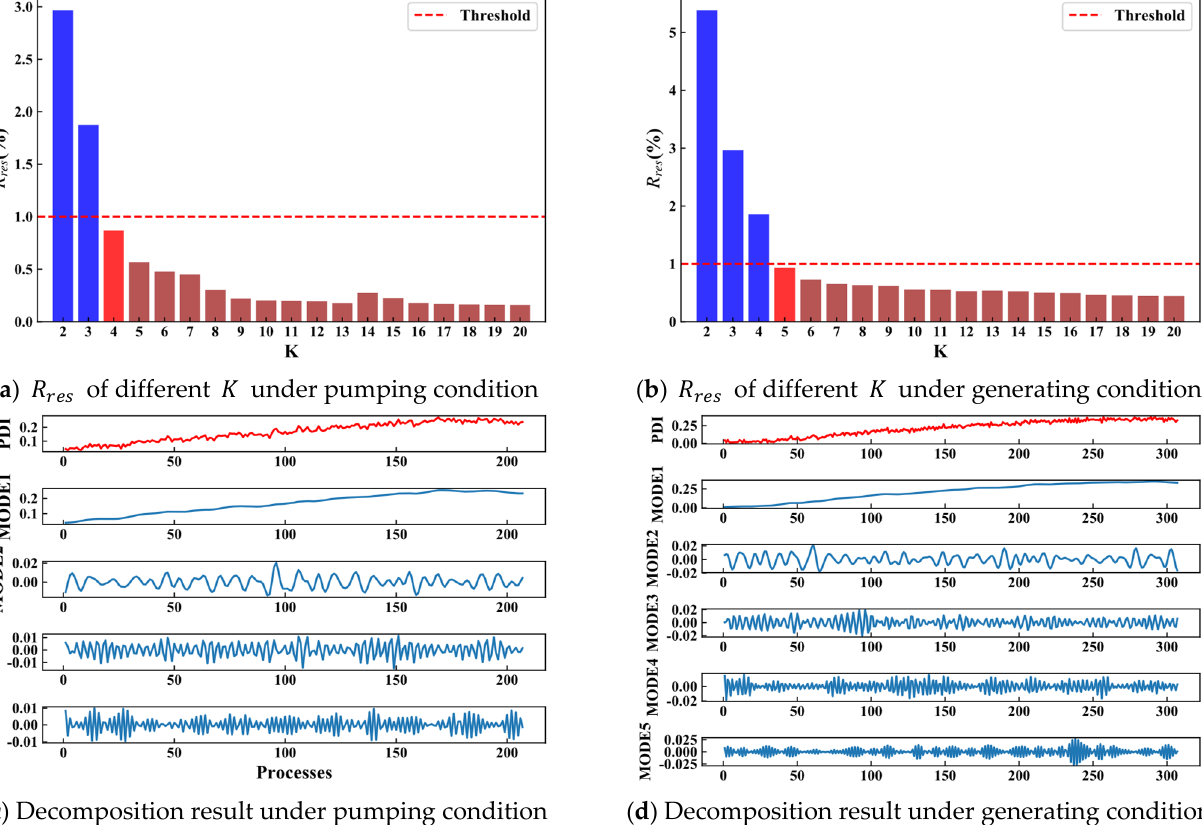
Figure 12. Decomposition results of PDI sequences by VMD.